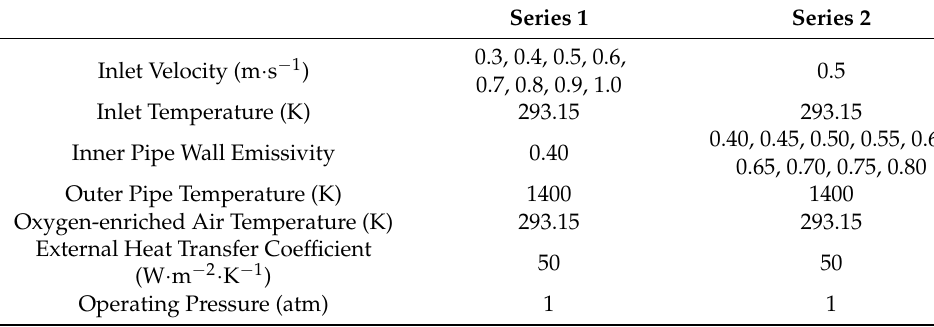
Table 2. Operating conditions for